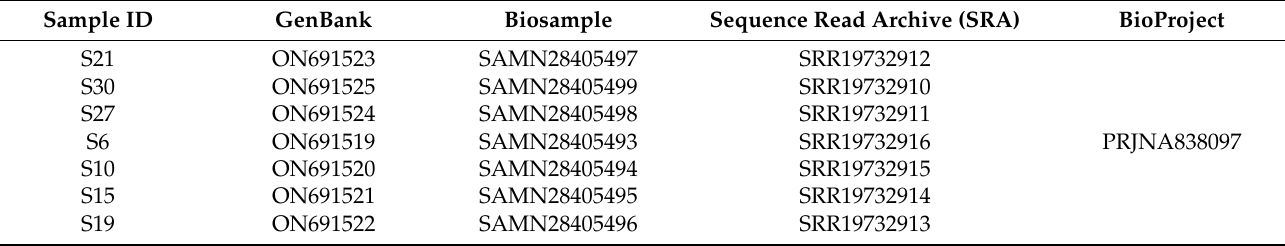
Table A2. Information on the data accessibility on the NCBI